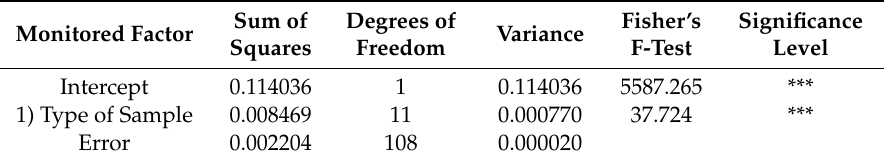
Table 5. Statistical evaluation of the e ff ect of the factors and their interaction on the coe ffi cient of wood bendability ( K bendC ) for beech and NWC on the